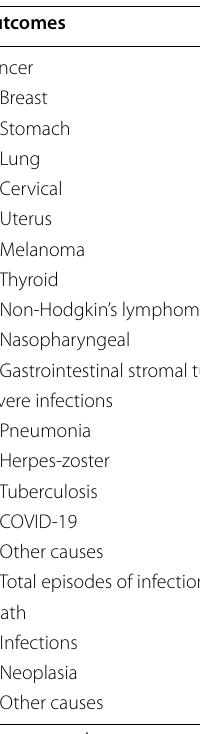
Table 3 Outcomes during